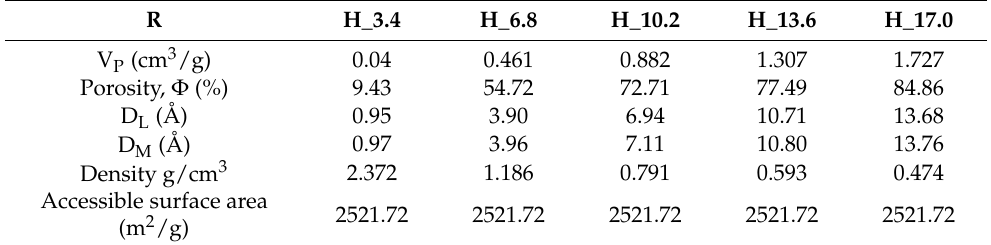
lium (0.26 nm) is approximately equal to the corresponding layer distance. According to